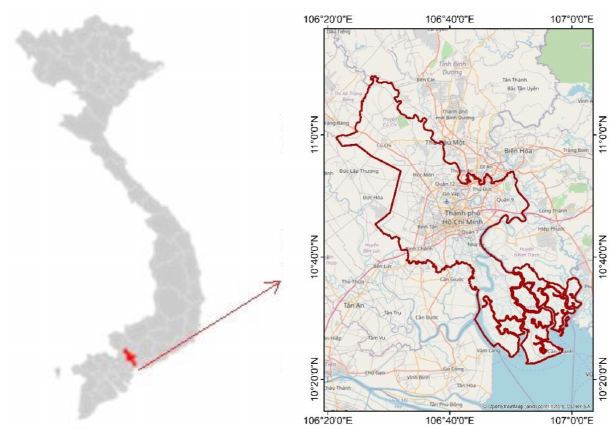
Figure 1. Ho Chi Minh City – inventory domain of our EI (© Open- StreetMap contributors 2019. Distributed under a Creative Com- mons BY-SA